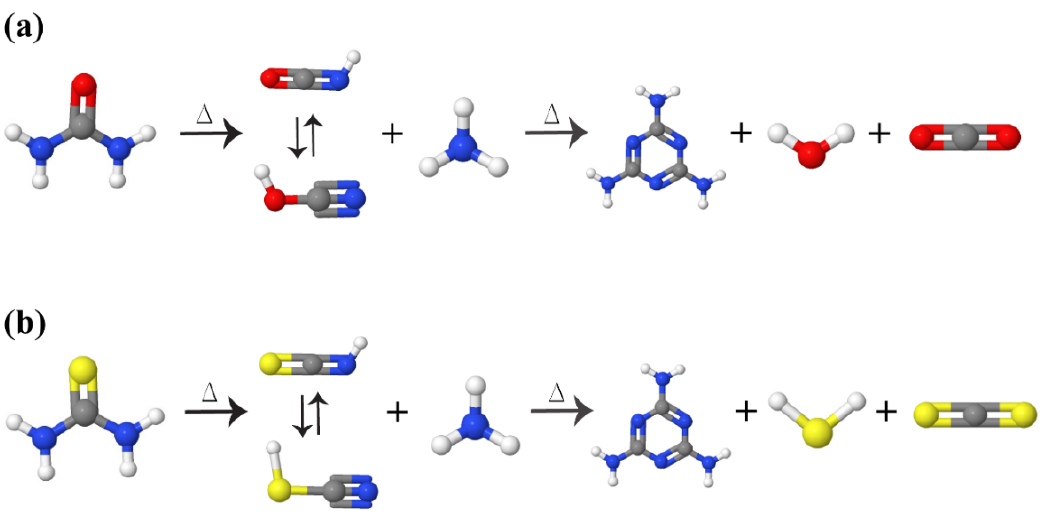
Figure 7. Polymerization of ( a ) urea and ( b ) thiourea into a g-C 3 N 4 at high temperatures (gray, blue, red, yellow, and white balls are carbon, nitrogen, oxygen, sulfur, and hydrogen atoms, respectively).